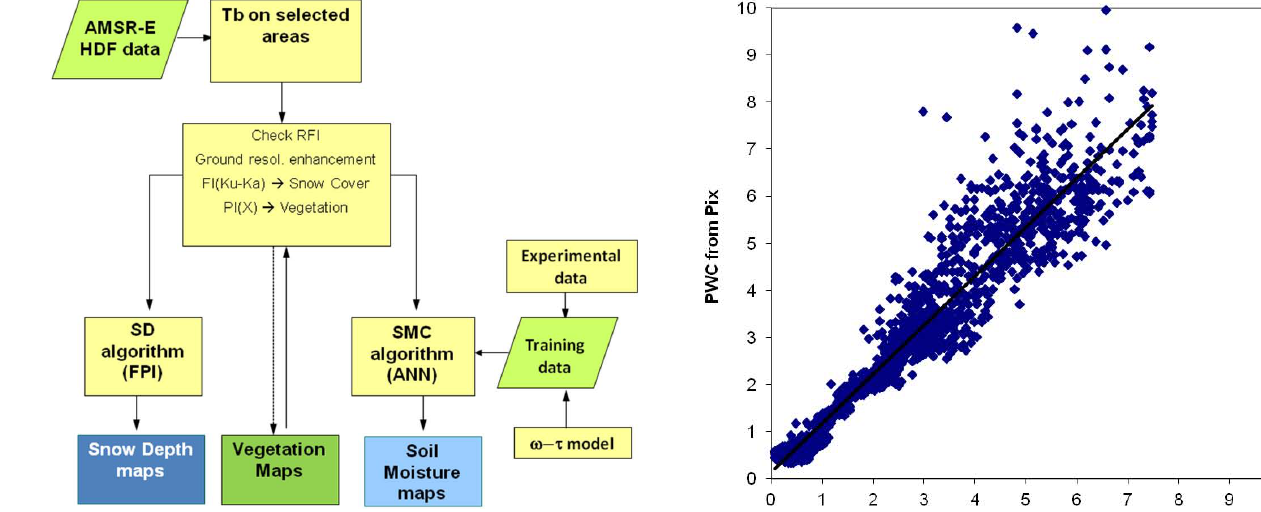
− 2 ) estimated from the X-band Polarization index, compared to the PWC estimated from NDVI, for a large area in Africa (0–20 ◦ N/16 ◦ –17 ◦ E). The line represents the regression equation.